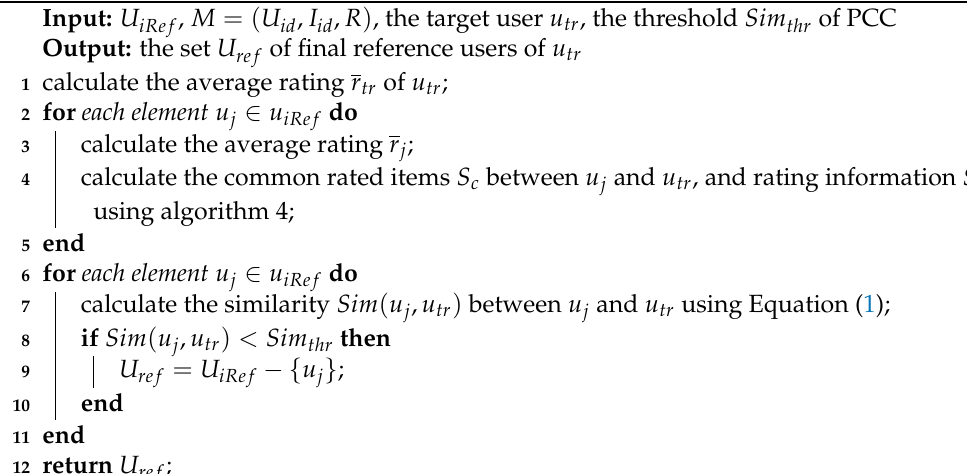
Algorithm 3: Determining the reference users of a target user—Step 2: determining the final reference users of the target user u